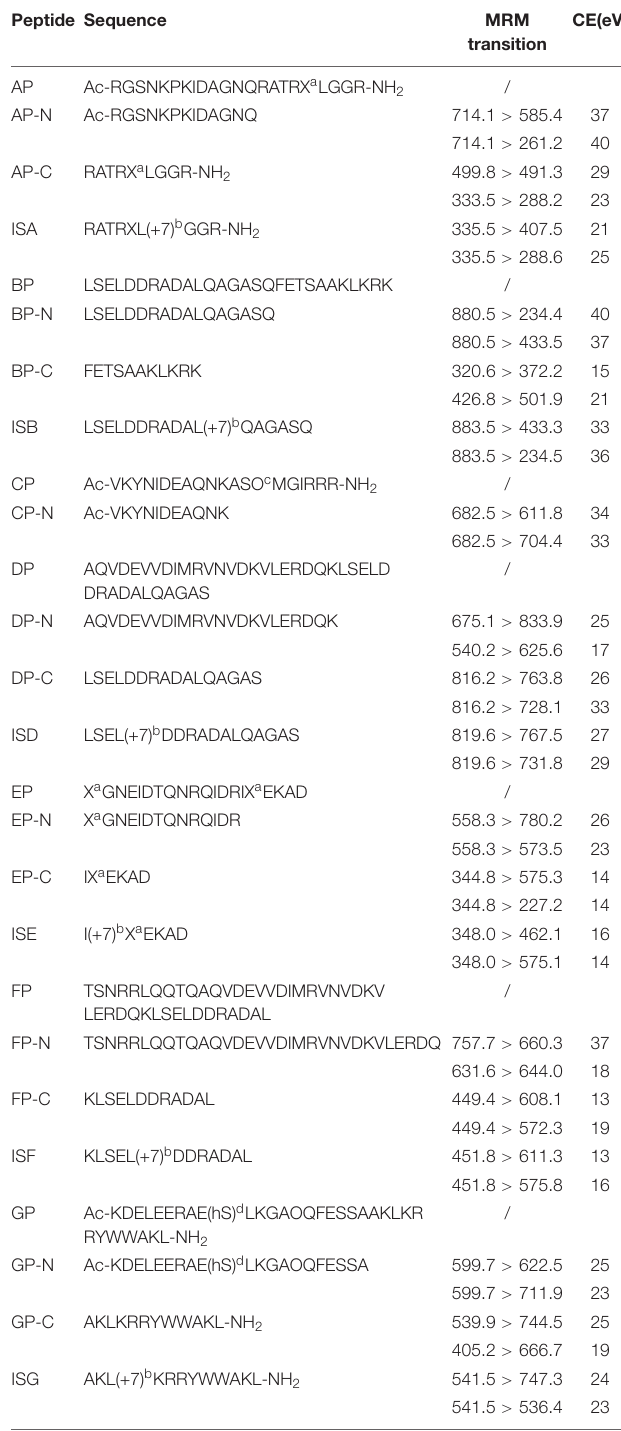
TABLE 1 | Peptide sequences of substrates, cleavage products, and internal standards for serotypes A–G. Peptide Sequence